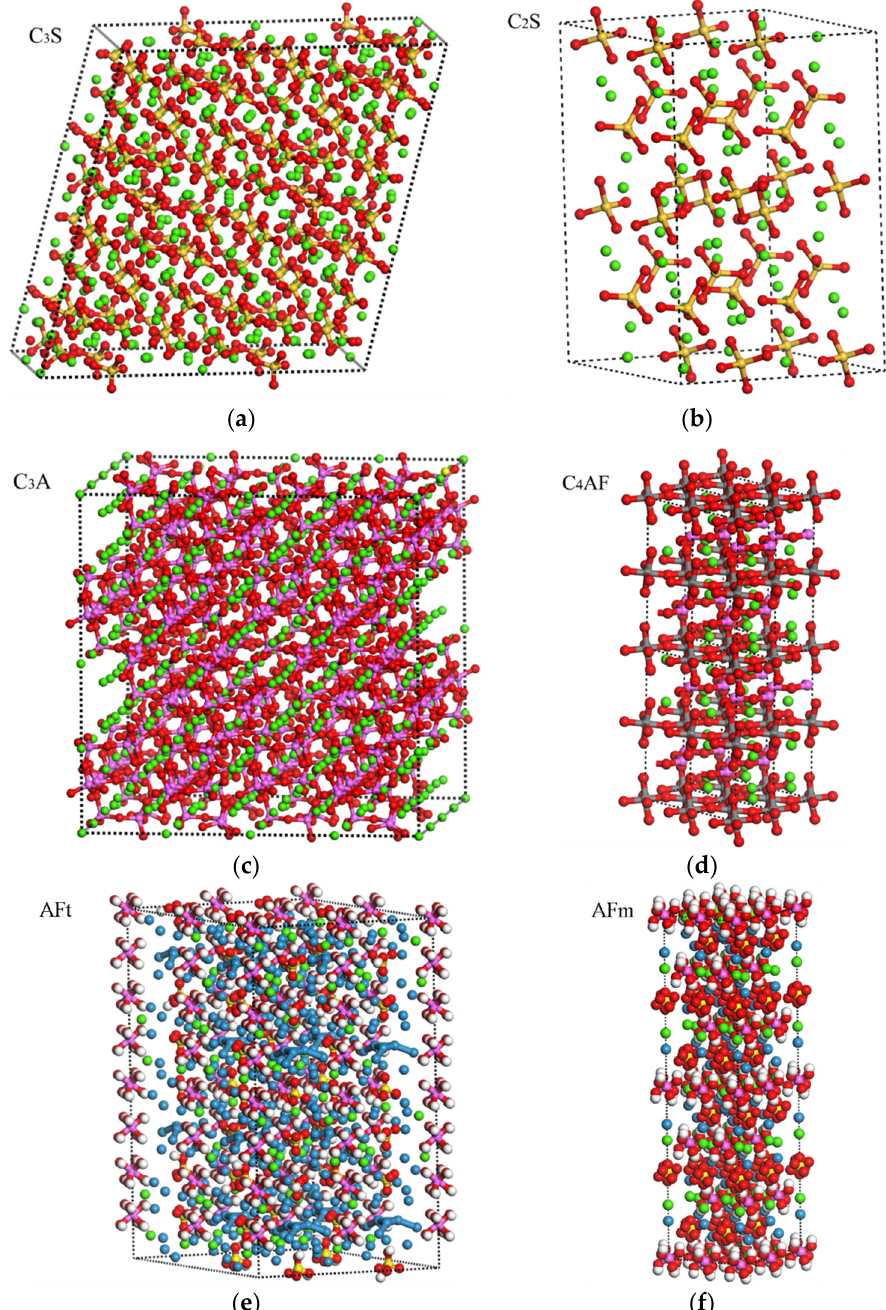
Figure 4. A 2 × 2 × 2 supercell molecular structure of crystal minerals (the white, red, blue, yellow, pink, grey and green balls represent the H, O, S, Si, Al, Fe and Ca atoms, respectively): ( a ) C 3 S, ( b ) C 2 S, ( c ) C 3 A, ( d ) C 4 AF, ( e ) AFt, ( f ) AFm.